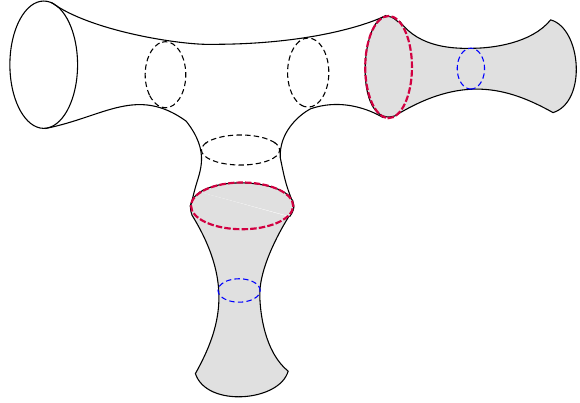
Figure 19 . A situation where the original black hole (unshaded) has a pair of pants region behind the horizon with two separate EOW branes (red), each entangled with separate radiation systems (shaded regions).